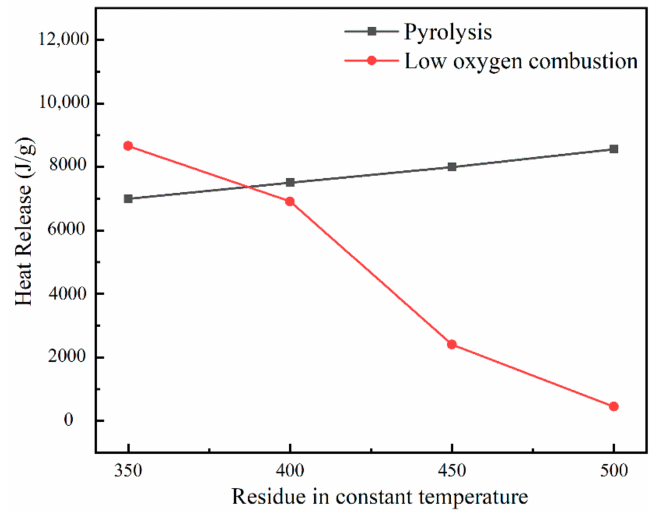
Figure 11. The variation tendency of the heat